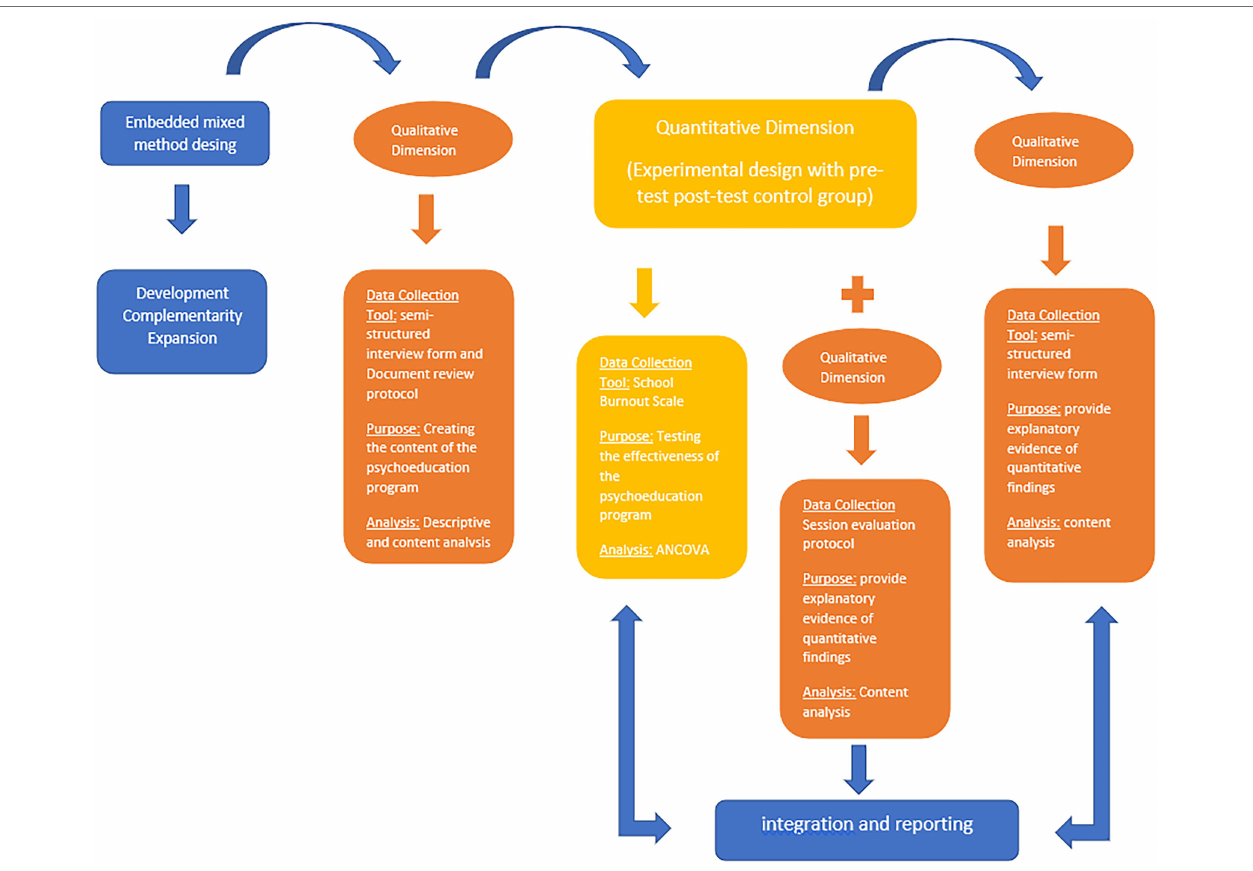
FIGURE 1 | Research